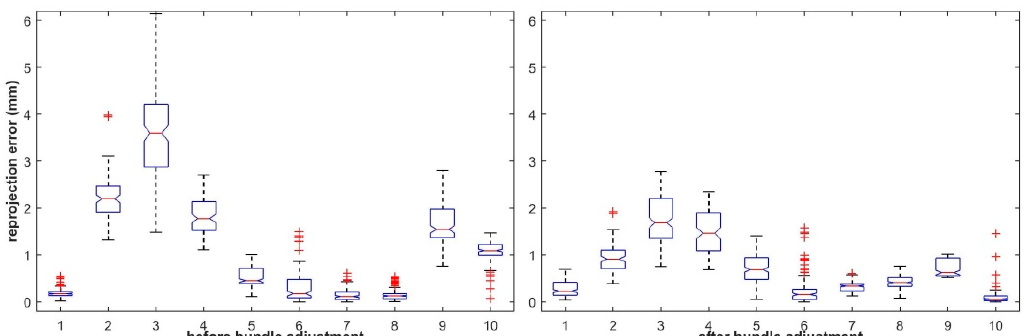
Figure 7. Reprojection errors of the initial and rectified points in the RLCS.